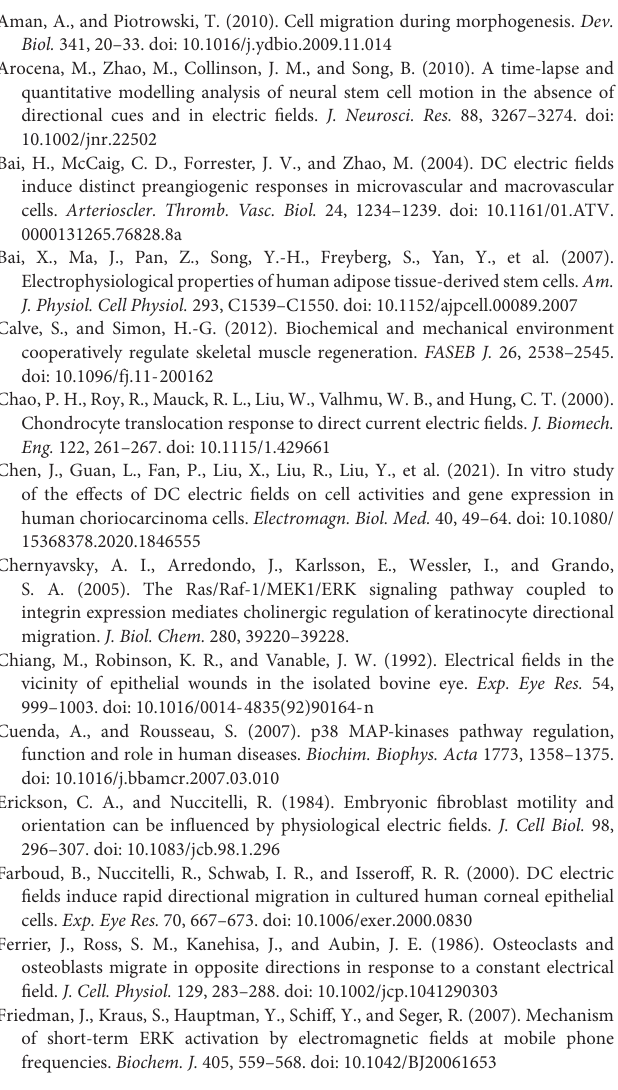
Supplementary Figure 5 | Effects of various inhibitors on EF-induced wound healing response of HK-2 cells. Inhibition of Erk1/2 (Erk1/2-i), p38 (p38-i), and Akt (Akt-i) significantly decreased the cell sheet of the cathode-facing side moving toward the cathode (c to c’, d to d’, and e to e’) during a 6 h culture period (C–E) , while the no inhibitor treated cells in the presence of EF (B) showed the cell sheet of the cathode-facing side moving toward the cathode (b to b’). The no EF control